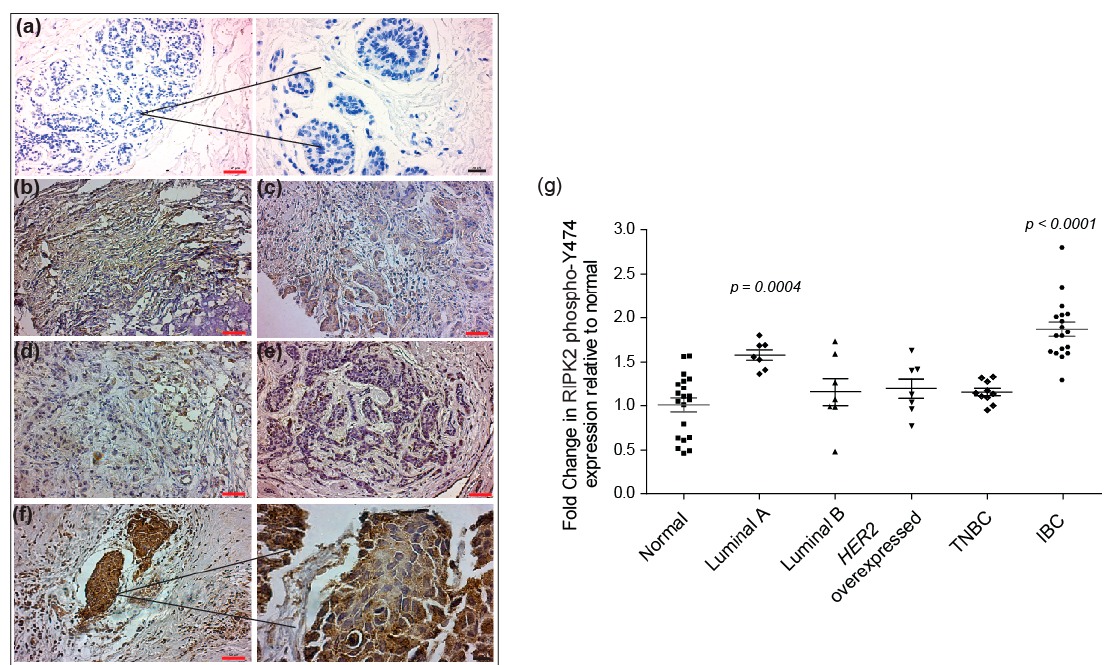
Figure 3. Immunohistochemical staining of normal non-neoplastic breast: ( a ) luminal A; ( b ) luminal B; ( c ) HER2 overexpressed; ( d ) triple negative breast cancer (TNBC); ( e ) and IBC; ( f ) using RIPK2 phospho-Y474 antibody). Breast tissue was stained and visualized using horseradish peroxidase-conjugated secondary antibody and 3, 3 ′ diaminobenzidine (DAB; brown), red scale bar: 50 µm, black scale bar: 20 µm. DAB staining of luminal A ( n = 7), luminal B ( n = 8), HER2 overexpressed ( n = 7), TNBC ( n = 10) and IBC ( n = 18). Tissue was quantified using the ImageJ platform permitting integrated optical density assessment of regions of interested in each slide. ImageJ analyzed images were then normalized to normal breast tissue ( n = 17) imaged in a similar manner; and ( g ) the plot represents the fold change in RIPK2 phospho-Y474 expression in tumor tissue relative to normal non-neoplastic breast tissues. p -value is calculated against normal breast tissue. All breast cancer tissues were isolated from patients after neoadjuvant chemotherapy treatment. A description of our patient population is documented in Table 1 (in the Materials and Methods Section 4.3).